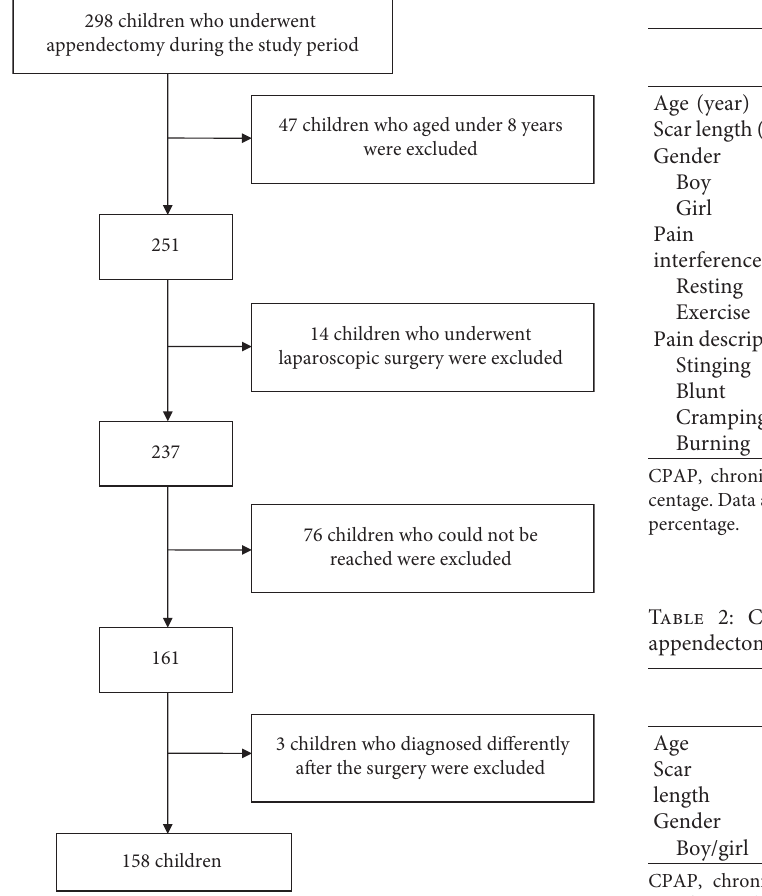
Figure 1: Flow chart.